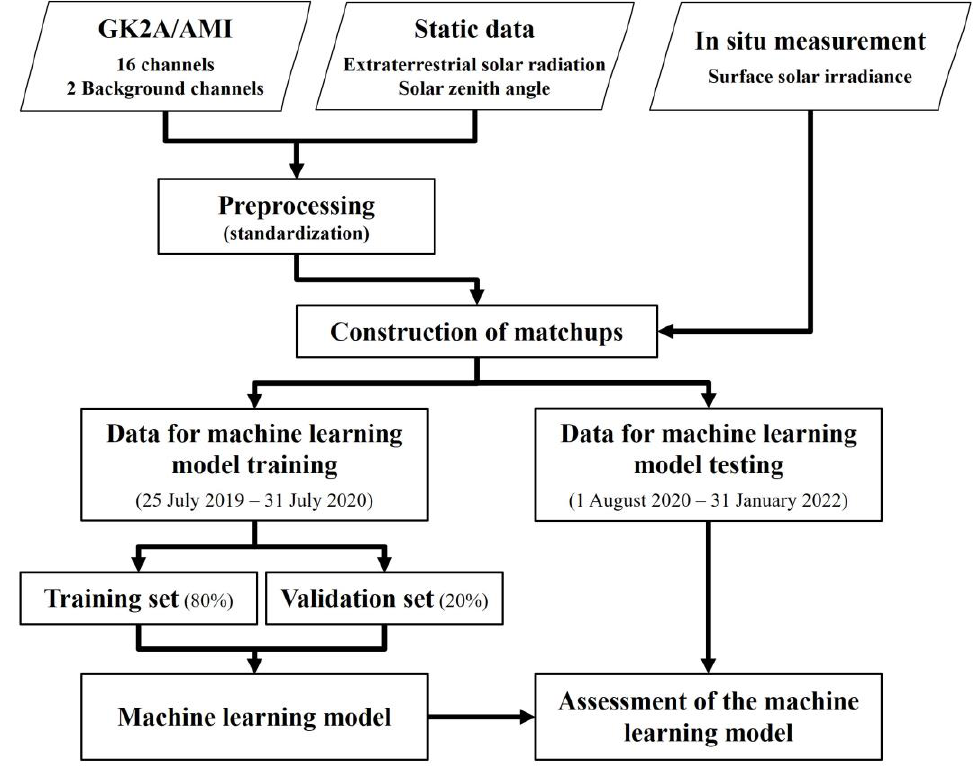
Figure 3. Flowchart describing the process of training and testing the surface solar irradiance (SSI) retrieval model using a machine learning (ML) approach.